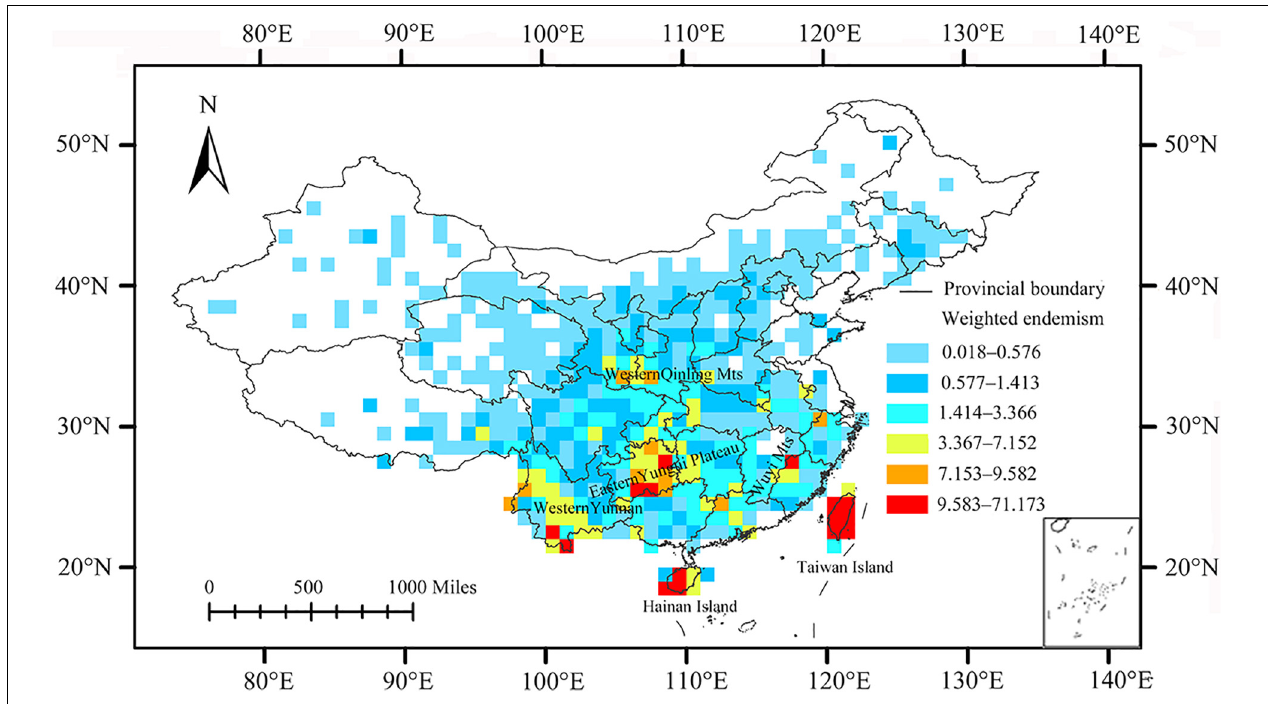
FIGURE 3 | Weighted endemism richness patterns of planthoppers in 1 ◦ grid in